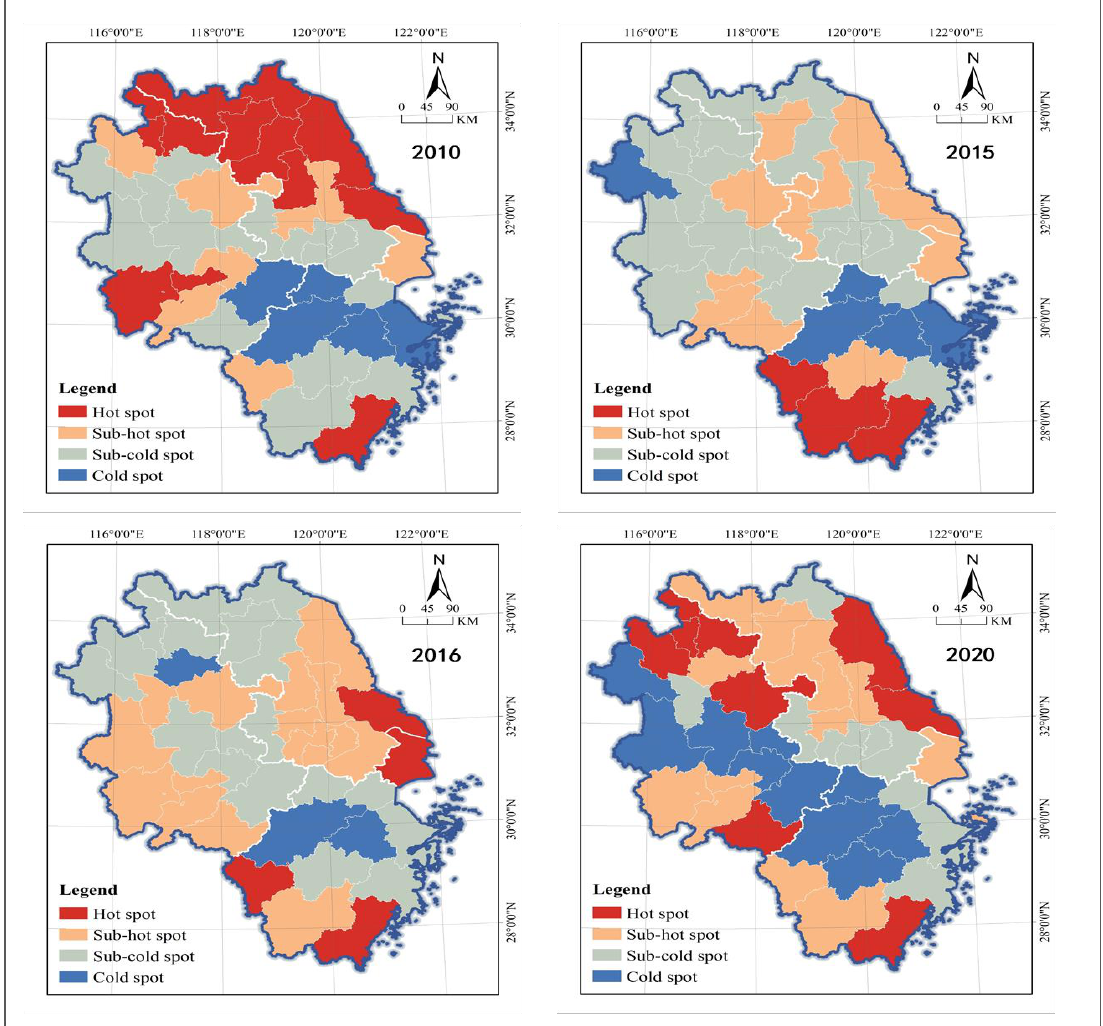
Figure 8. Analysis on the hot and cold area of pure technical efficiency in Yangtze River Delta. The maximum values of pure technical efficiency indexes in 2011, 2015, 2016, and 2020 were 1.59 (Suqian), 2.54 (Lishui), 1.41 (Lishui), and 1.71 (Chuzhou), respectively, with an N-shaped variation. The minimum values were 0.29 (Jiaxing), 0.34 (Suzhou-AH), 0.51 (Shaoxing), and 0.55 (Huzhou), showing a rising trend. The cities in effective status reached 51.22%, 58.54%, 58.54%, and 56.10%, respectively, and the average technical efficiency indexes of effective cities were 1.16, 1.16, 1.11, and 1.14, respectively, while the average ineffective city indexes were 0.56, 0.61, 0.70, and 0.72, respectively (Table 4). There were a small number of super-efficiency cities, relatively dispersed for a long time in geographical distribution. The efficiency cities were distributed in a band, mostly clustered in Anhui in 2011 and expanding along the central region of the province toward Jiangsu. Most cities gather in Jiangsu in 2015 and expanded along the central part towards Anhui. In 2016, they were clustered in western Anhui, the coastal zone of Jiangsu, and the Nanjing metropolitan area, largely balanced in Jiangsu and Anhui. Most cities gather in Jiangsu in 2020 and extended to the Hefei metropolitan area in Anhui. In 2011, the inefficiency cities